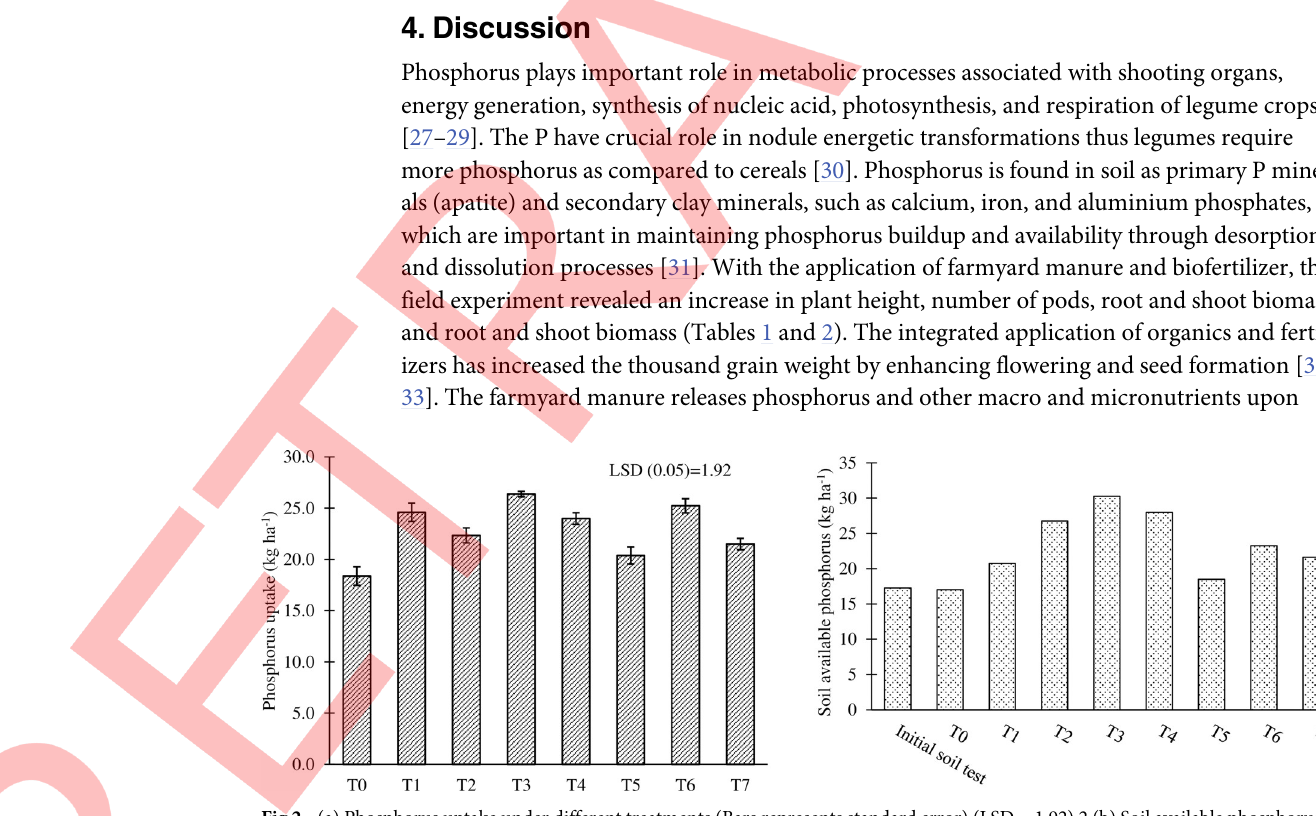
Fig 2. (a) Phosphorus uptake under different treatments (Bars represents standard error) (LSD = 1.92) 2 (b) Soil available phosphorus under different treatments before